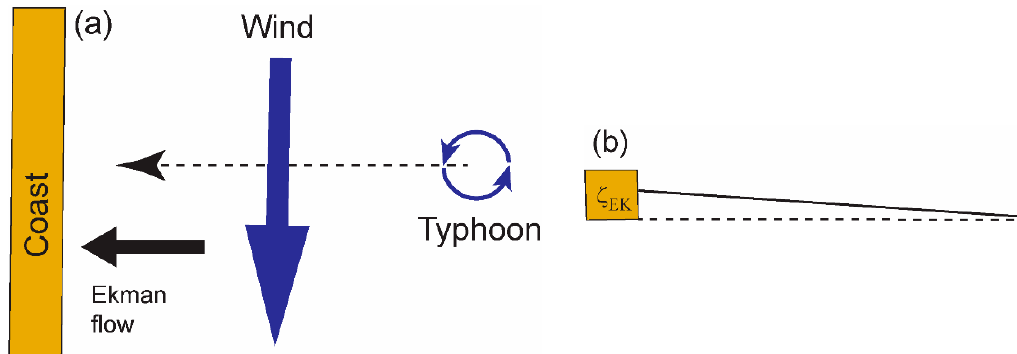
Figure 1. ( a ) Schematic of the mechanics of forerunner formation in the northern hemisphere. When the typhoon is far from the coast, shore parallel winds and alongshore currents drive an onshore Ekman flow; and ( b ) a cross-shelf schematic of the Ekman set-up, ζ EK .